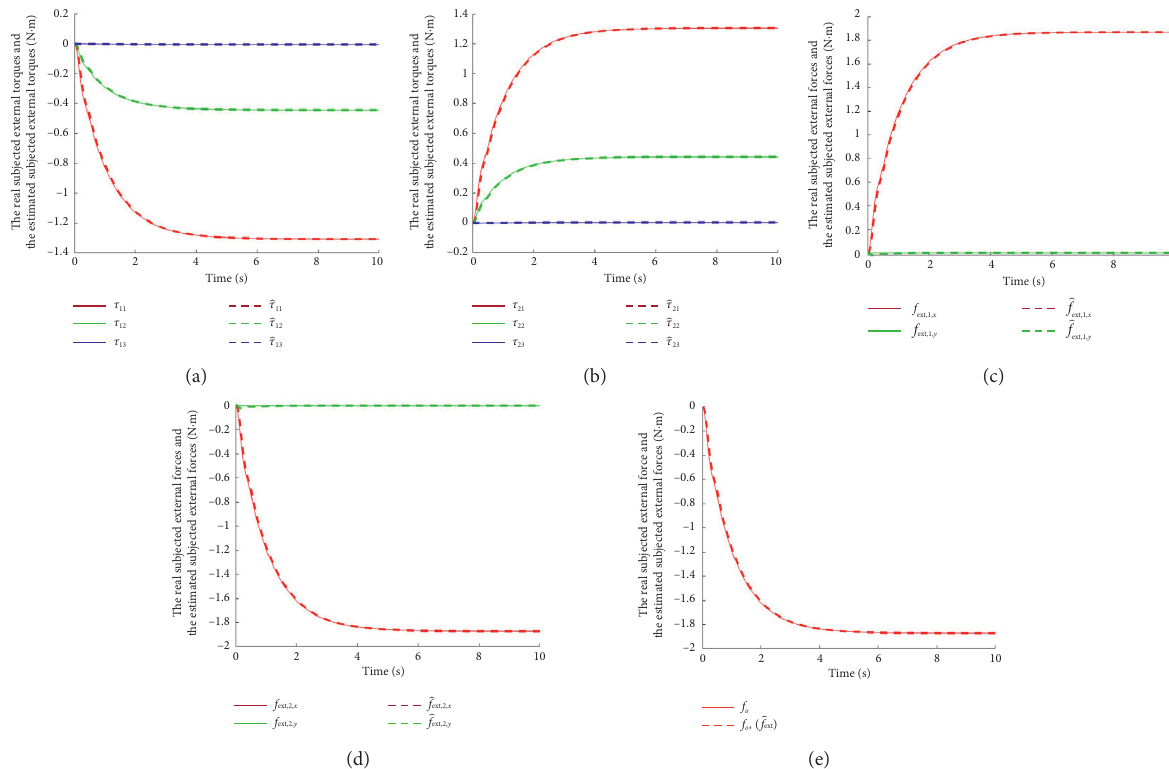
Figure 9: Some other system states corresponding to the simulation of Figure 8(g). (a) Subjected joint torques in robot 1. (b) Subjected joint torques in robot 2. (c) Subjected external force in EE 1. (d) Subjected external force in EE 2. (e) Object’s internal force.